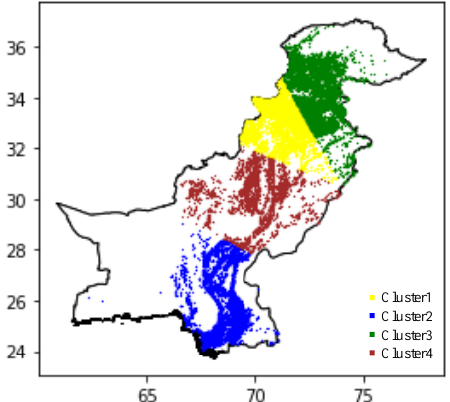
Figure 17. Random forest AUC variation in four different seasons. Spatial relatability of model: Although the data-driven strategy was studied at the country scale, the relative features showed considerable distinction for different clusters in Pakistan, as shown in Figure 18. To investigate if the driven data variation resulting from spatial variation had a significant influence on the fire occurrence, four density-based clusters with distinct features were chosen for analysis. K-means is a simple technique for clustering analysis. Its aim is to find the best division of n entities into k groups (called clusters), so that the total distance between the group’s members and corresponding centroid, irrespective of the group, is minimized. Each entity belongs to the cluster with the nearest mean. This results in a partitioning of the data space into Voronoi cells. We used K-mean clustering for spatial location to divide the dataset into four density-based clusters [96].